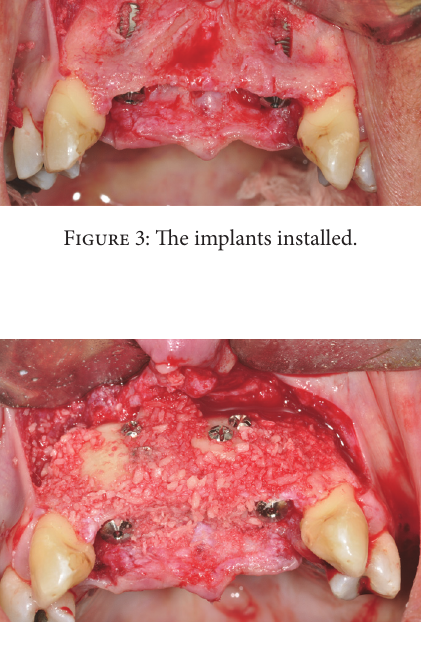
Figure 4: Bone blocks fixed with miniscrews and particulate